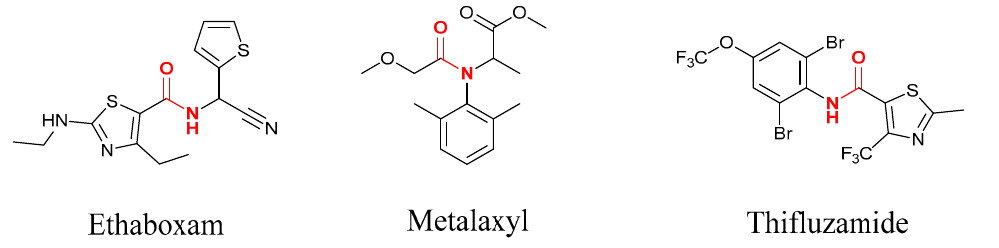
Figure 2. Typical commercial amide fungicides.